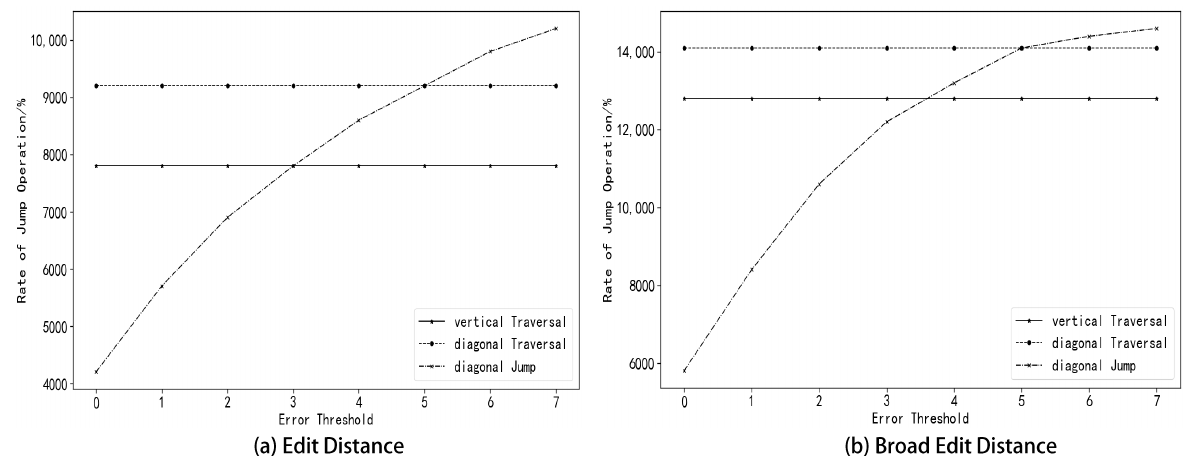
Figure 9. Edit distance average execution